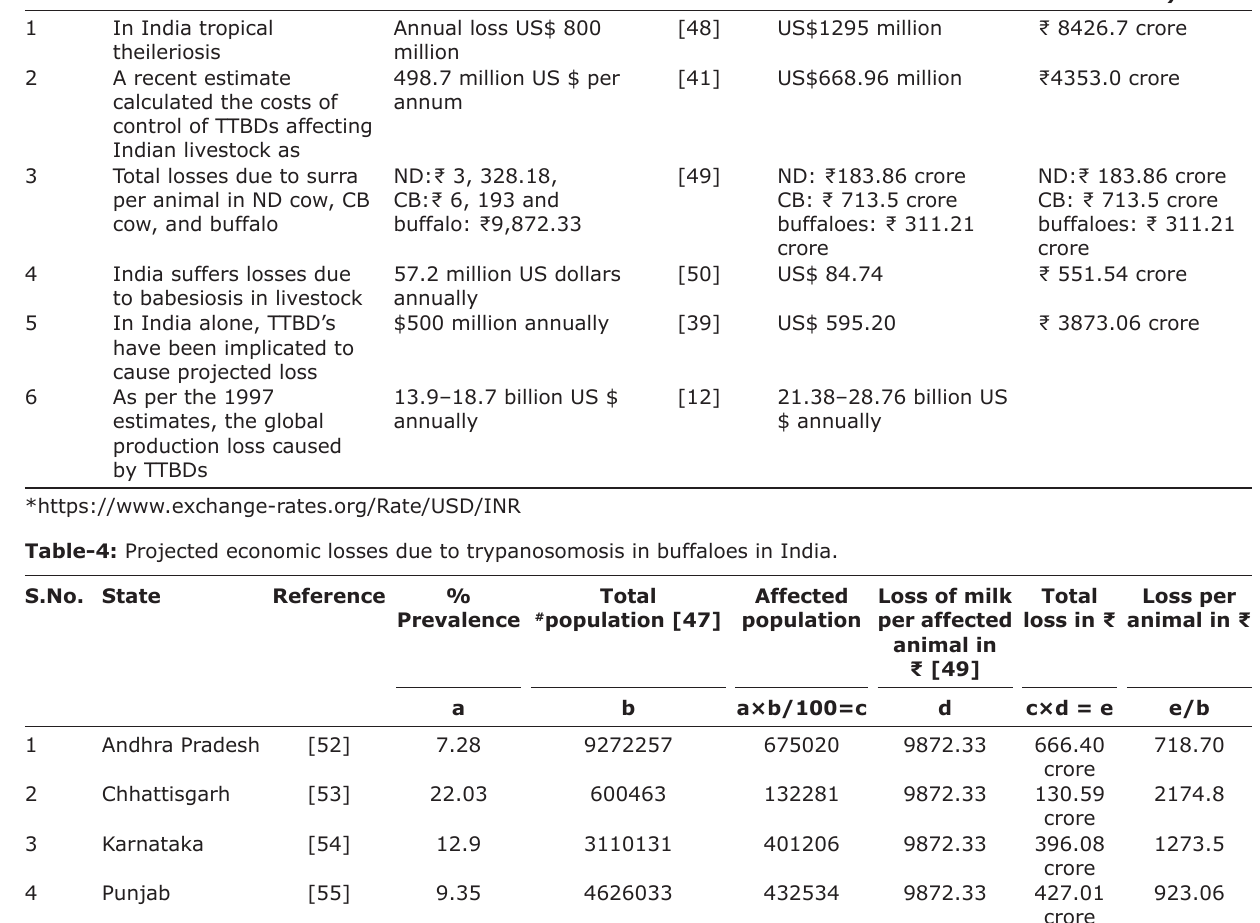
Table-3: Losses due to TTBD reviewed from the literature. S.No. Disease transmitted by vector